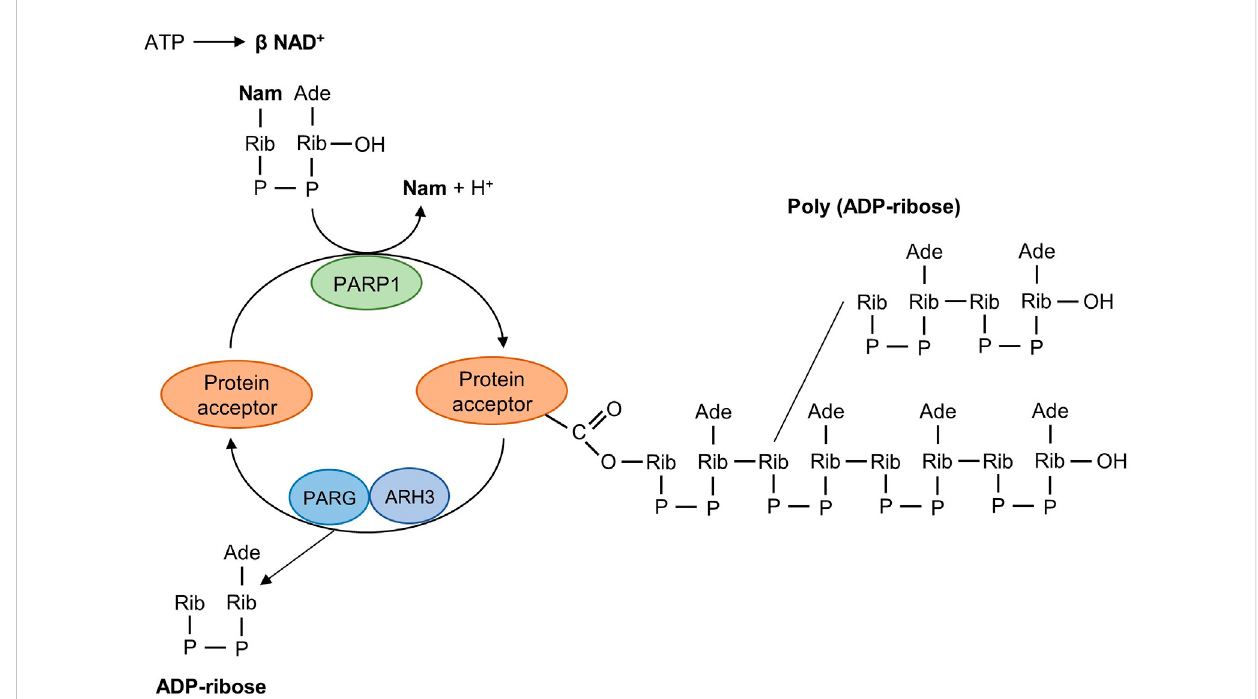
FIGURE 2 Mechanism of poly (ADP-ribosyl)ation reaction catalyzed by PARP1. PARP1 detects DNA strand breaks, hydrolyses NAD + , and catalyzes the transfer of ADP-ribose units on amino acid residues of protein acceptors. The poly (ADP-ribosyl)ation reaction is reversible and the degradative nuclear enzymes PARG and ARH3 cleave poly (ADP-ribose) into ADP-ribose units. PARG, poly (ADP-ribose) giycohydroiase; ARH3, poly (ADP-ribose) hydrolase-3; Nam, nicotinamide; Ade, adenine; Rib, ribose; P,